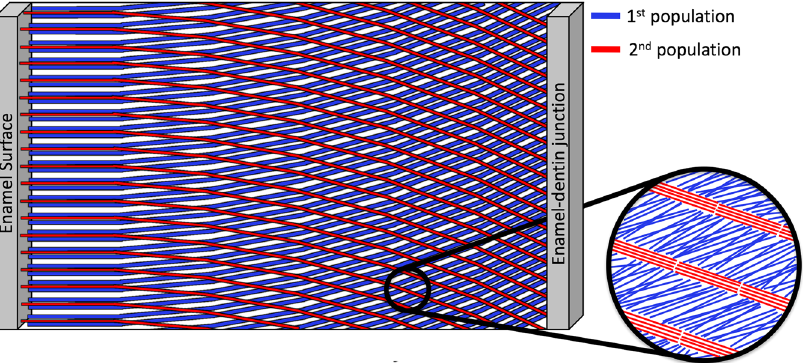
Figure 7. A proposed model representing the texture magnitude and direction of the two orientation populations as they span the enamel thickness. The thicker the lines, the lower the texture magnitude and the higher the number of lines, the higher the population